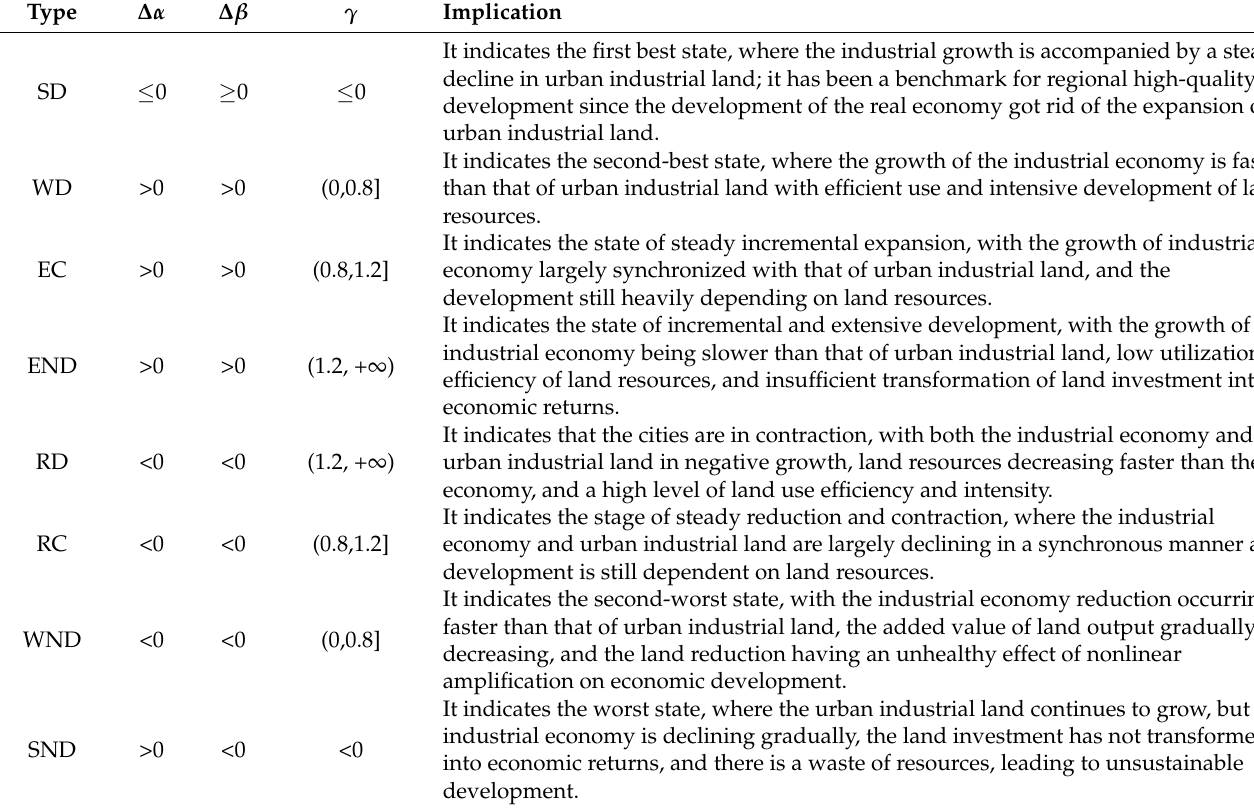
Table 3. Decoupling type and decoupling indicator